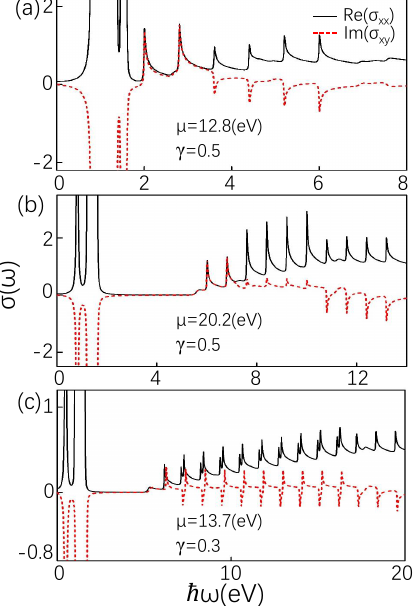
Figure 3. ( a , b ) The Re ( σ xx ) (solid curve) (in units of e 2 ) compared with Im ( σ xy ) (dotted curve) 2 π l B (in units of e 2 ) are plotted for µ = 12.8 eV and µ = 20.2 eV. The effect of tilt term on the optical 2 π l B conductivity in units of e 2 . ( c ) Re ( σ xx ) and Im ( σ xy ) are plotted in γ = 0.3 and µ = 13.7 eV. The 2 π l B parameters B = 0.8 T, and T = 0.01 K. Other parameters are the same as in Figure